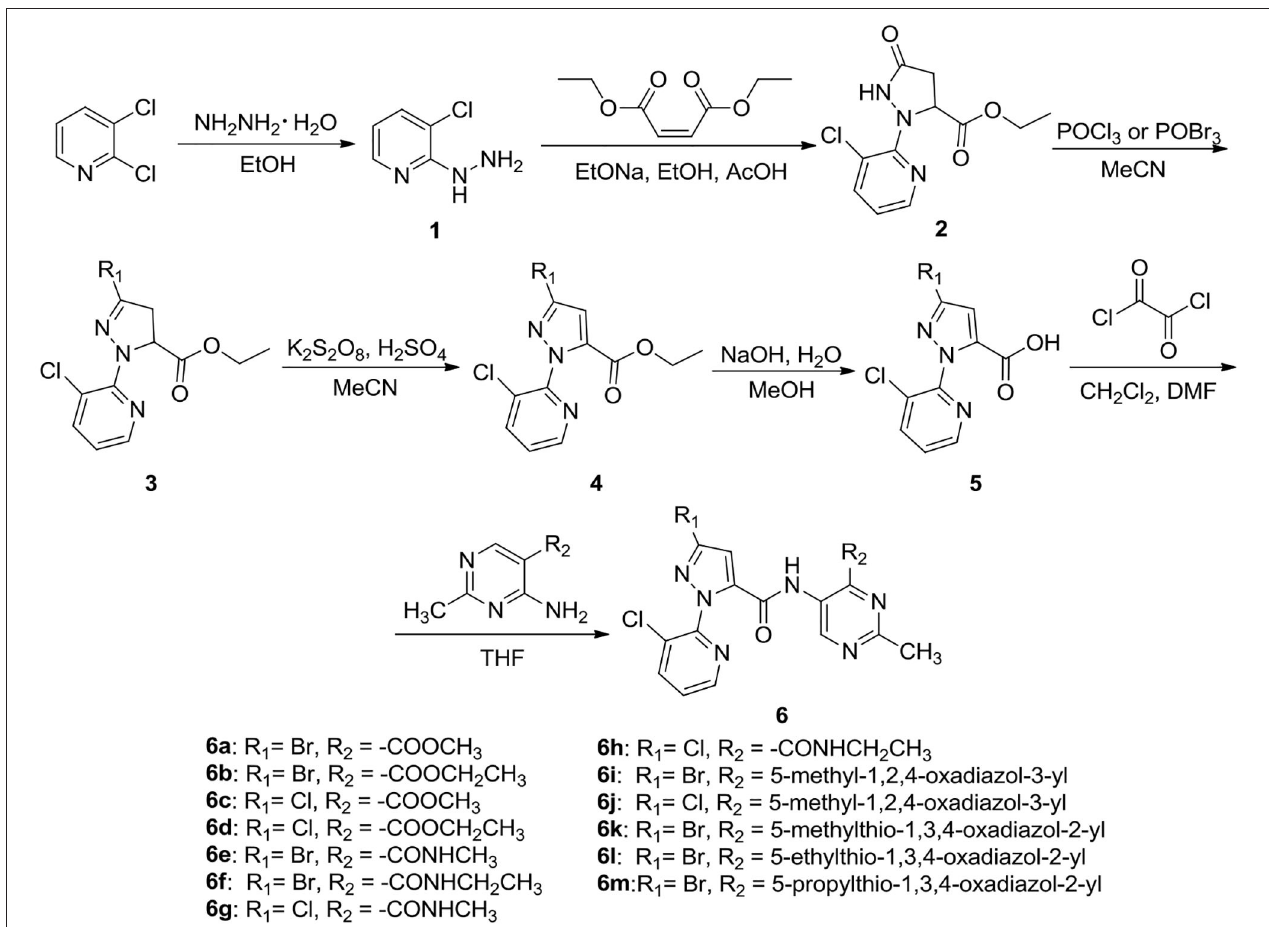
SCHEME 1 | Synthetic route of the title compounds 6a – 6m